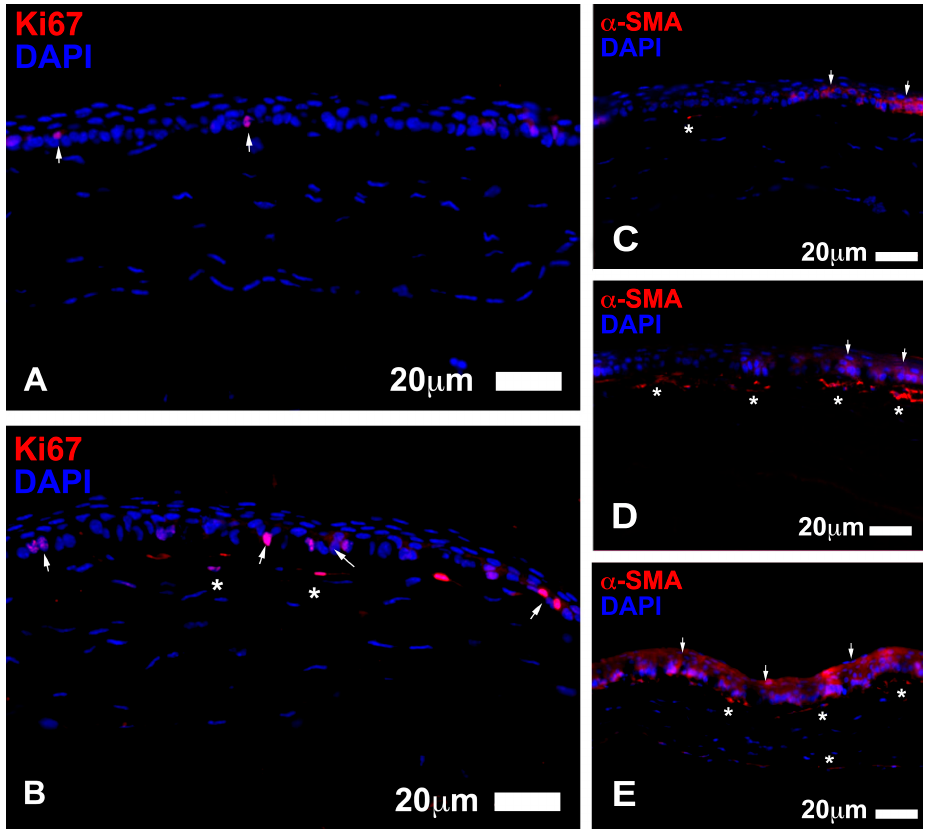
Figure 7. Left panel shows examples of proliferative events in the central epithelium 7 days after injury. In the ADSC treated eyes ( A ), there were scarce residual amounts of Ki67+ cells (in red, arrows), which can normally found in the epithelium uninjured corneas. There were no proliferative elements found in the stroma. In contrast, the control eyes ( B ) showed numerous Ki67 positive cells located both in the central epithelium (arrows) and stroma (asterisks). Right panel shows α -SMA staining (in red) during corneal wound healing 7 days after injury. The ADSC eyes showed a very low number or absence of myofibroblasts in the stroma (( C ), asterisk). Control eyes exhibited strong staining to α -SMA in the upper stroma with numerous filiform myofibroblasts (( D ), asterisks). The basic serum treated eyes also showed a high number of α -SMA+ myofibroblasts in the stroma (( E ), asterisks). The epithelium showed a diffuse staining to α -SMA in all cases (arrows), which varied and did not appear to be influenced by treatment (Scale bars: 20 µm).